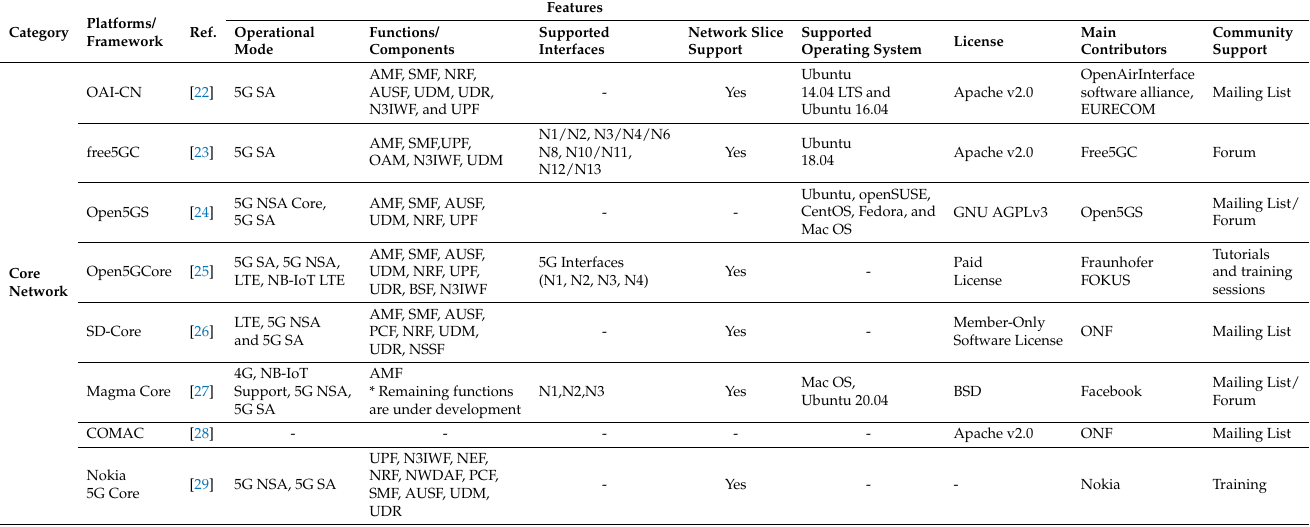
Table 2. Comparison of 5G Core Network Platforms and Framework Features